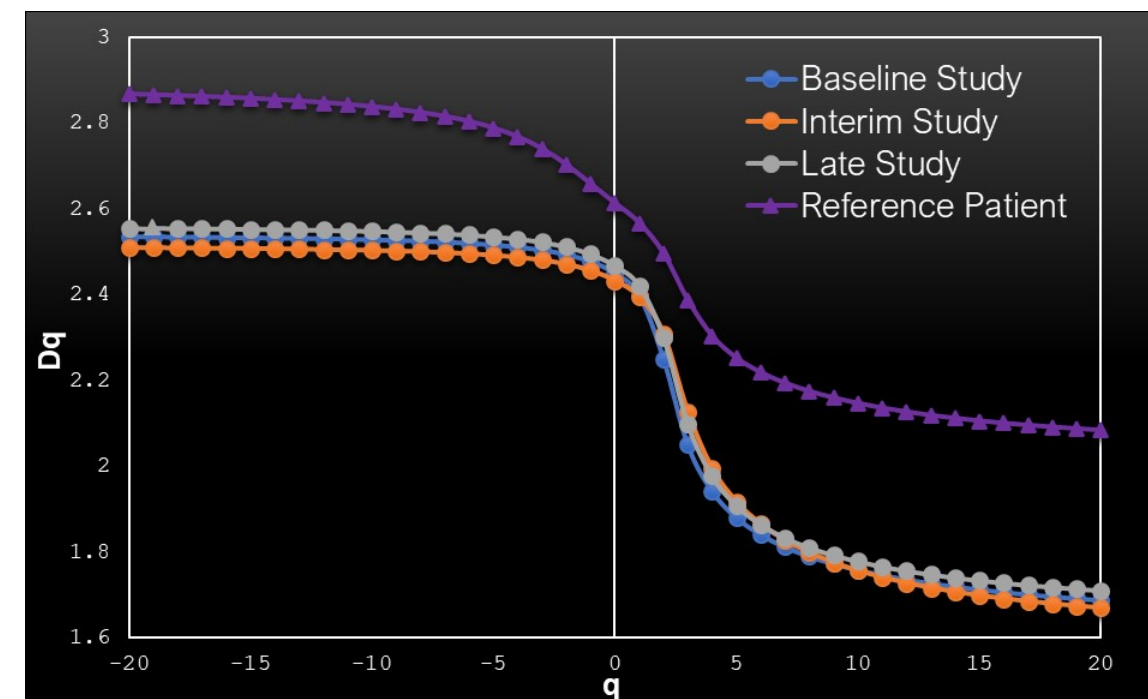
Figure 2. Typical MFS spectrum of patient with SMD. The blue line corresponds to the baseline study of patient P12, the orange line corresponds to the interim study and the gray line to the final study of the same patient. For comparison, the purple line representing healthy control H5 is also depicted.